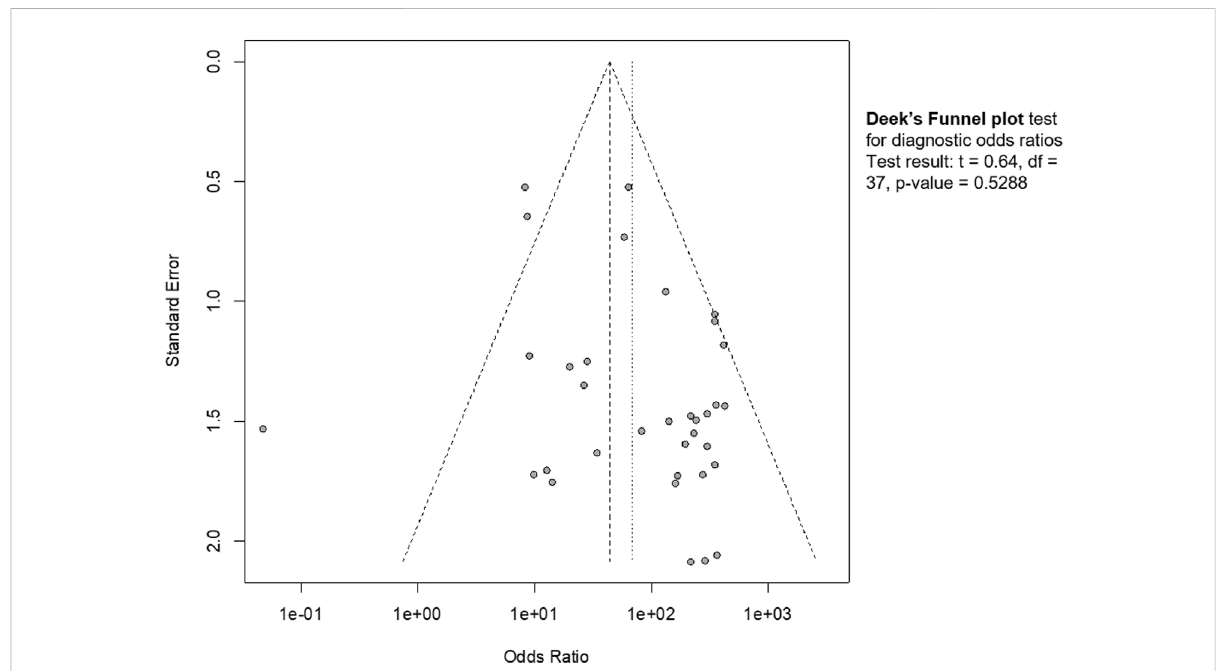
FIGURE 6 Funnel plot. The graphical representation showed no signi fi cant publication bias ( p =